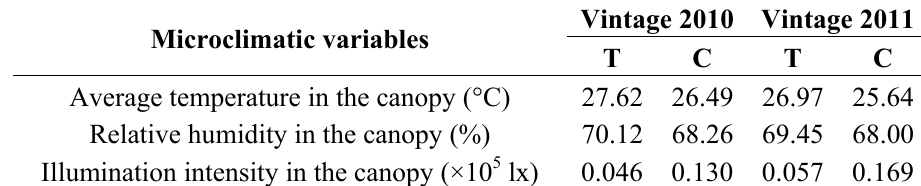
Table 3. Microclimatic parameters in the canopy of Cabernet Gernischet grape under rain-shelter (T) and open-field cultivation (C), respectively.